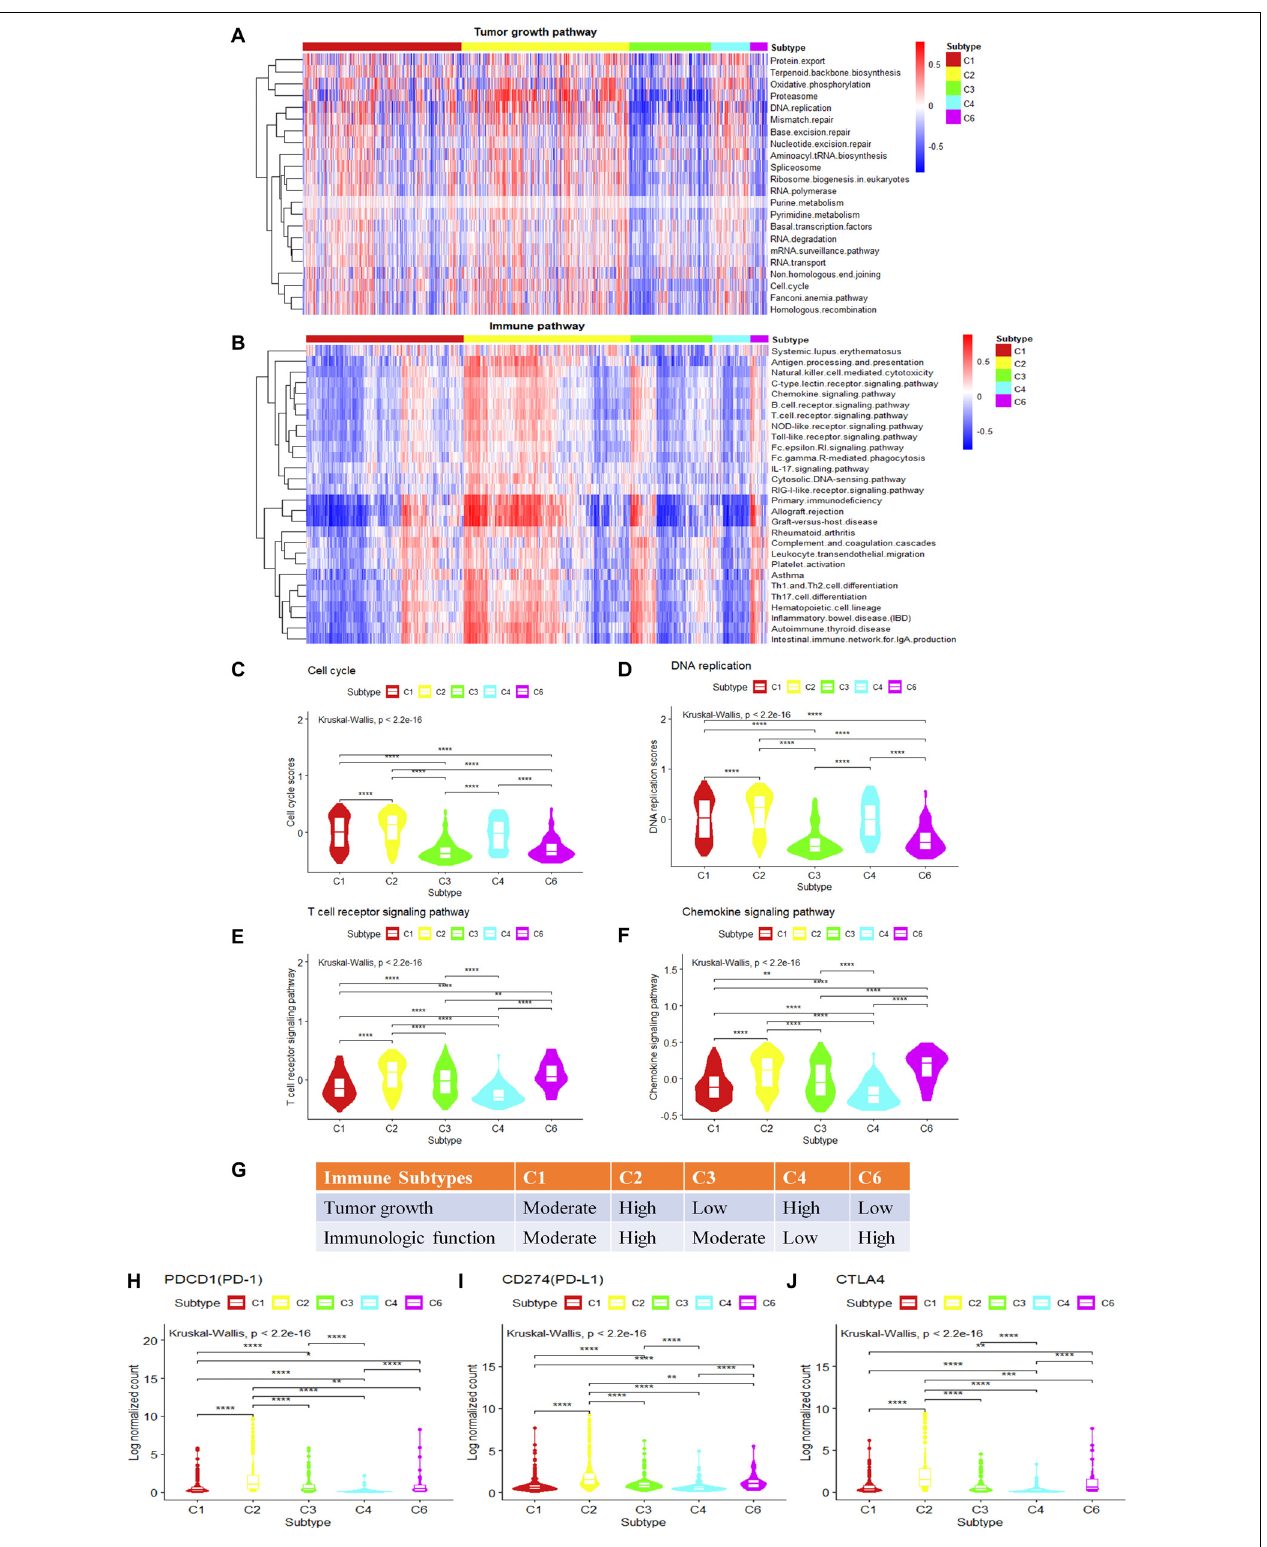
FIGURE 4 | Single-sample gene set variation analysis (ssGSVA) of immune-related pathways and tumor growth-related pathways for different immune subtypes in breast invasive carcinoma. (A,B) The heatmap shows the ssGSVA enrichment scores of breast invasive carcinoma immune subtypes in tumor